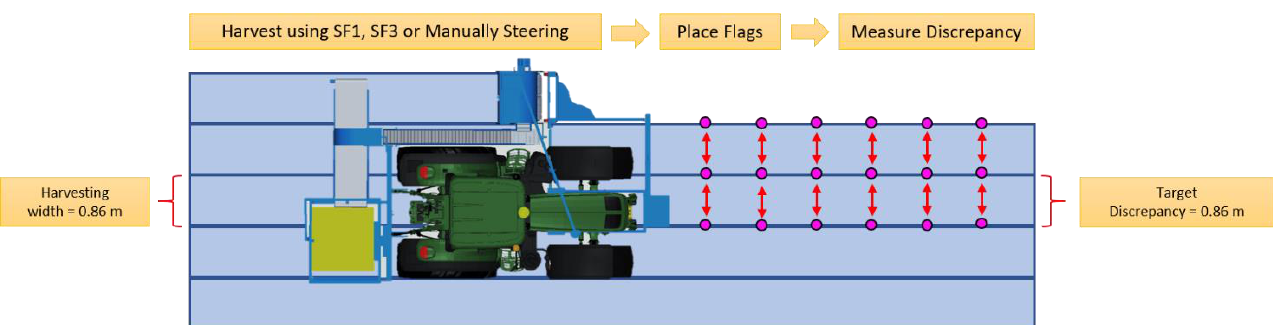
Figure 5. Schematic showing flag placement and measurements for determining pass-to-pass accuracies of John Deere’s SF1 and SF3 signal levels and manual steering.